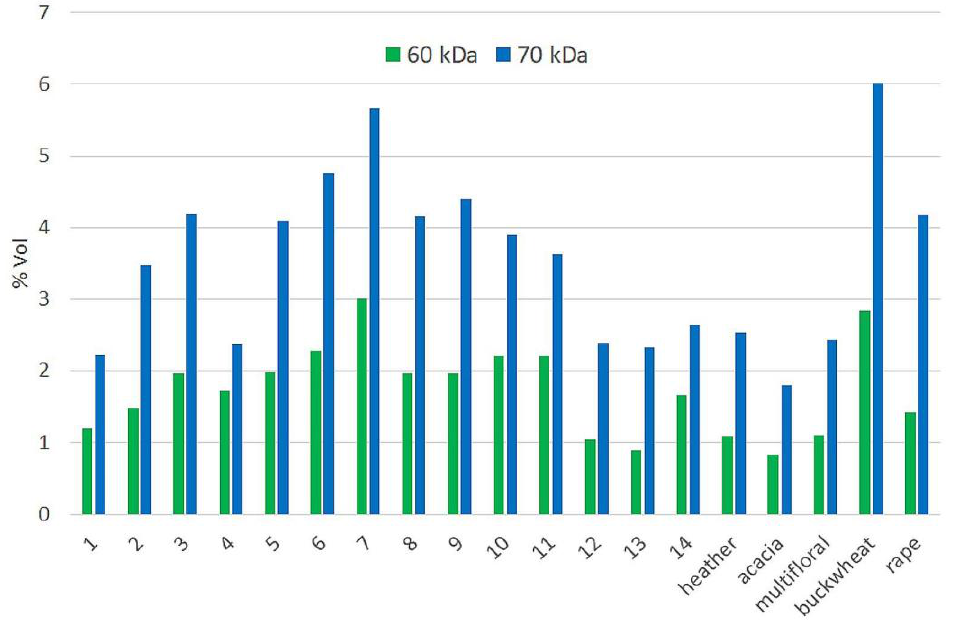
Figure 6. Quantitative analysis [%Vol parameter] of the two most intense bands on the CBB-G250 stained gel.